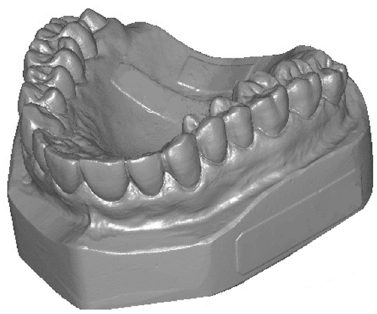
Figure 6. Second reference artifact.